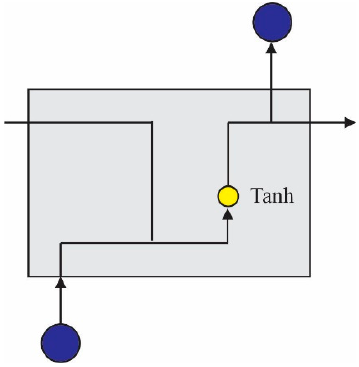
Figure 7. Illustration of an RNN cell.